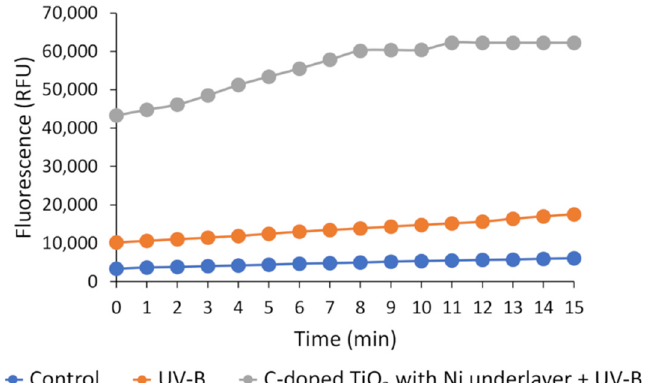
Figure 9. Intracellular ROS formation in S. typhimurium bacteria after the treatment of floating pho-